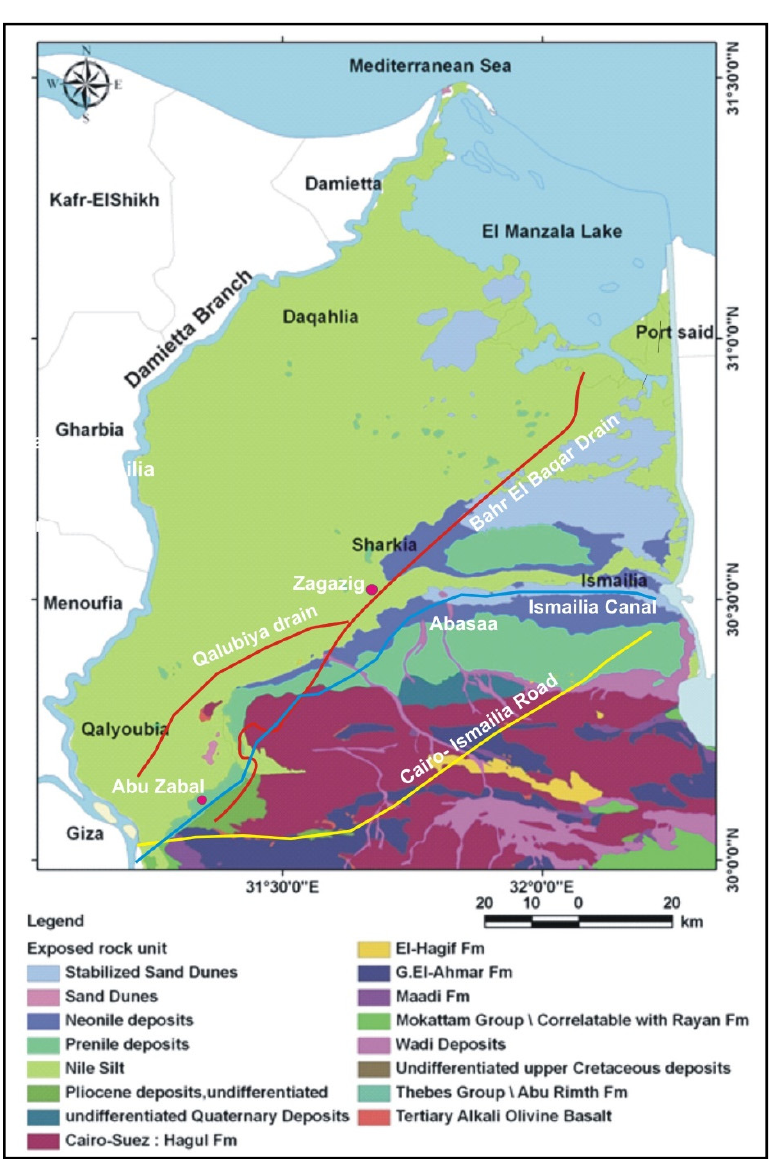
Figure 1. Geologic map of the eastern Nile Delta [21] (modified after [26]).